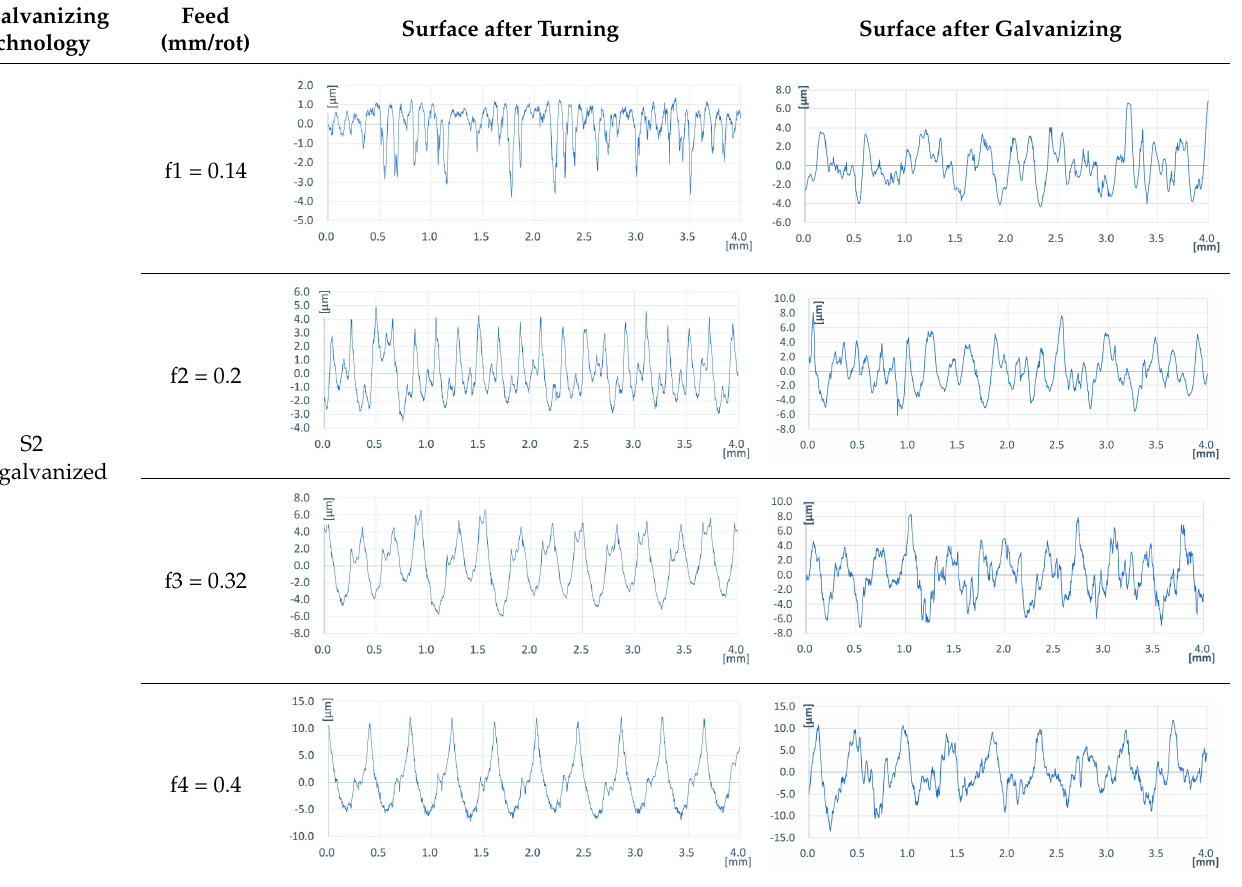
Table 13. Variation in the turned surface after galvanizing.